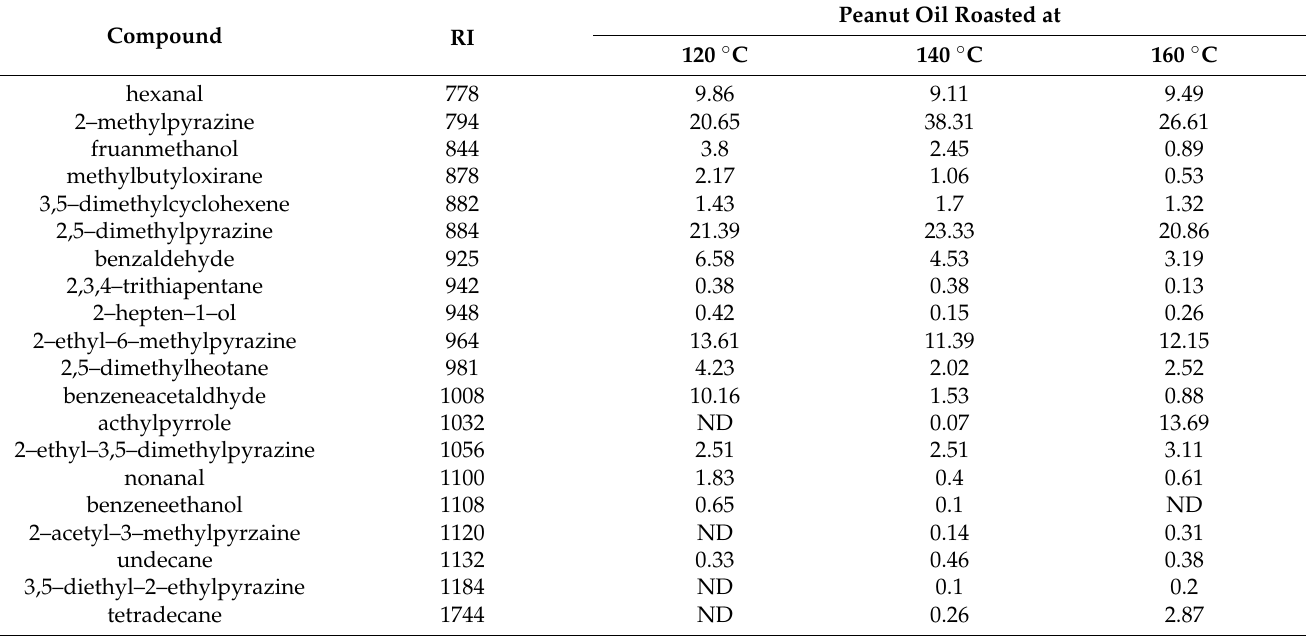
Table 4. Volatile compounds (%) in peanut oils was influenced by roasting